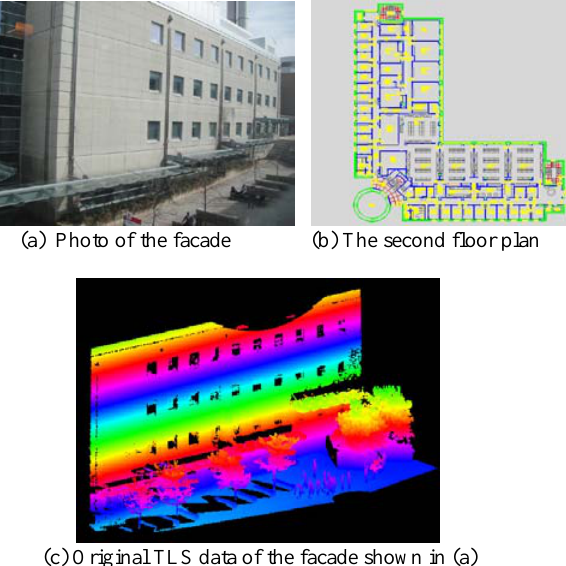
Figure 1. A flowchart of the main steps of the proposed method Then TLS wall lines at each cross-section level and floor plan wall lines of each storey are connected into line sequences respectively. Each line sequence is further decomposed into and represented by column vectors defined by using local transformation invariant information between two neighbouring line segments.